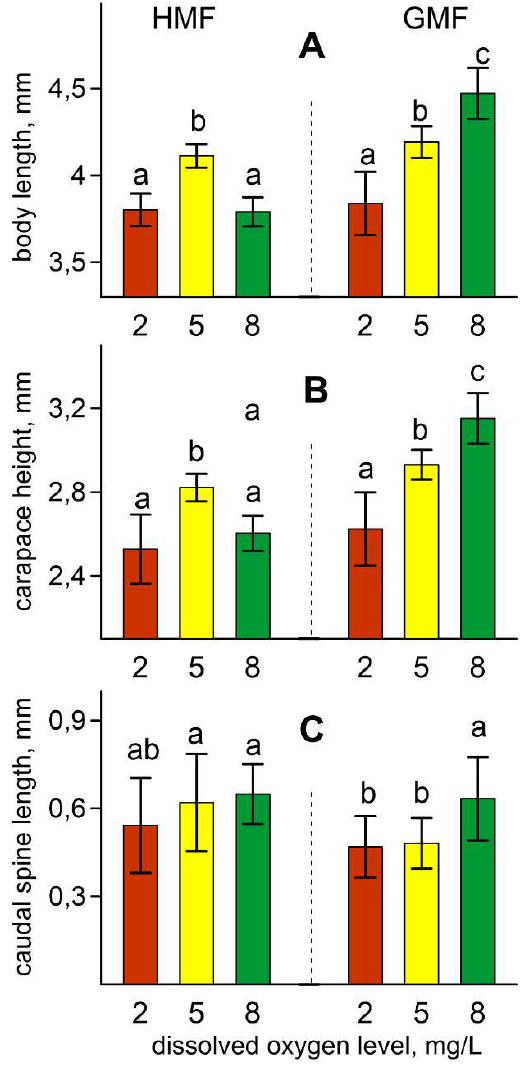
Figure 4. The body length ( A ), carapace height ( B ), and caudal spine length ( C ) in parental females. Values are means ± standard deviation. Different letters indicate significant differences among groups ( p < 0.05) after Tukey’s post-hoc multiple comparison tests. For all variables with the same letters, the difference between the groups is not statistically significant. Significantly different groups have different letters.